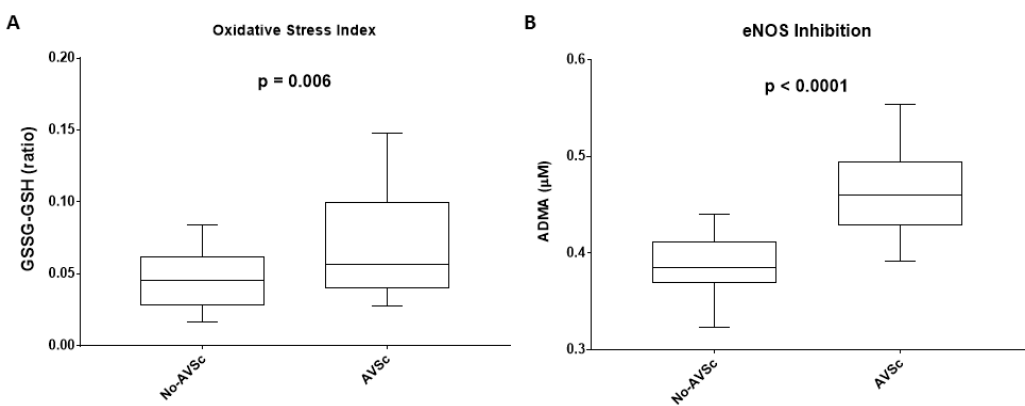
Figure 1. Imbalance of systemic glutathione homeostasis and endothelial dysfunction. ( A ) Box plot representing the ratio between the reduced (GSH) and the oxidized (GSSG) forms of glutathione in patients with normal aortic valve leaflet (No-AVSc; n = 29) and aortic valve sclerosis (AVSc; n = 29). ( B ) Box plot representing ADMA levels in patients with No-AVSc ( n = 29) and AVSc ( n = 29).